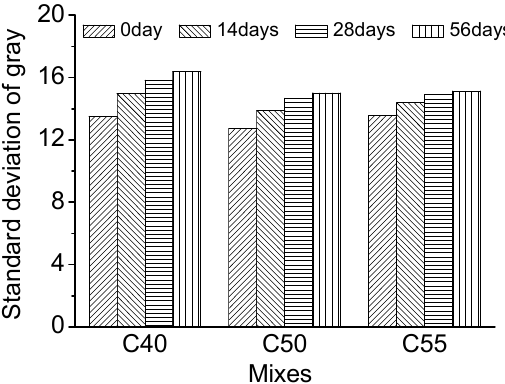
Figure 16. Standard deviation of gray of C40, C50, and C55 exposed to carbonation environment after different exposure times.